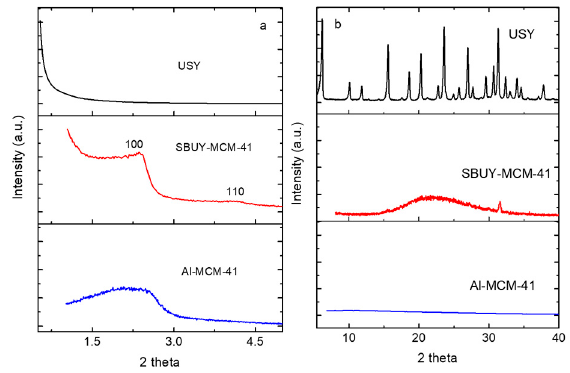
Figure 1. ( a ) Low-angle and ( b ) wide-angle XRD patterns of USY, SBUY-MCM-41, and Al-MCM-41.